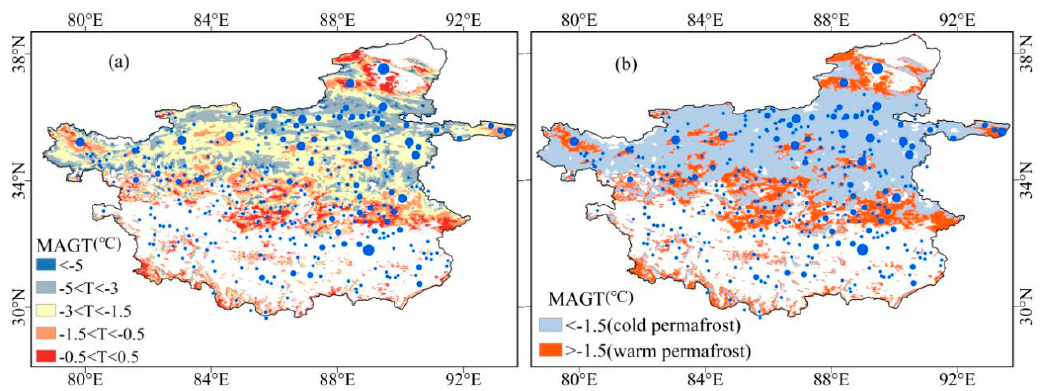
Figure 5. ( a ) The spatial patterns of lake expansion and the MAGT of the permafrost over the endorheic basin; and ( b ) the spatial difference of lake expansion in warm and cold permafrost over the endorheic basin. The black line contour is the QTP endorheic basin.